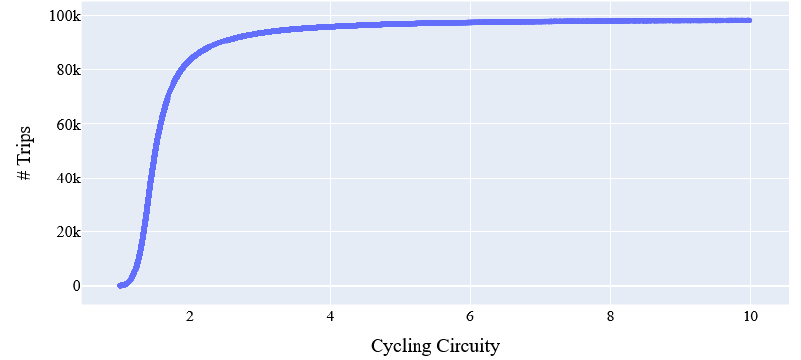
Figure 13. Distribution of cycling circuity values for all MSS cycling trips in